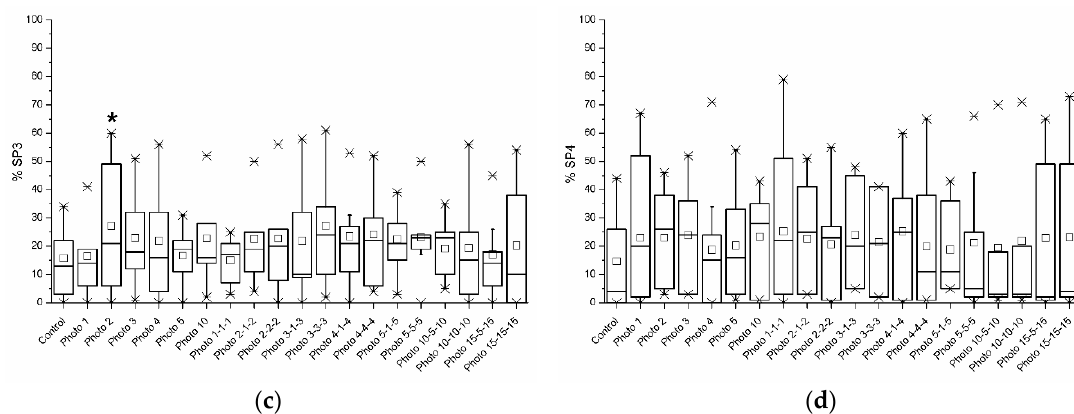
Figure 5. Box plots showing the percentages of sperm belonging to ( a ) Subpopulation 1 (SP1, which was the slowest subpopulation based on VCL, VSL, and VAP); ( b ) Subpopulation 2 (SP2, which presented intermediate values, higher than SP1 but lower than SP3); ( c ) Subpopulation 3 (SP3, which was the one with the highest VSL, VAP, and LIN); and ( d ) Subpopulation 4 (SP4, which was the one with the highest VCL and ALH but with the lowest LIN, STR, and WOB) in the control and different irradiation patterns. The superscript (*) means significant differences ( p ≤ 0.05) between the control and irradiation patterns. Data are shown as mean ± SEM of nine independent experiments.